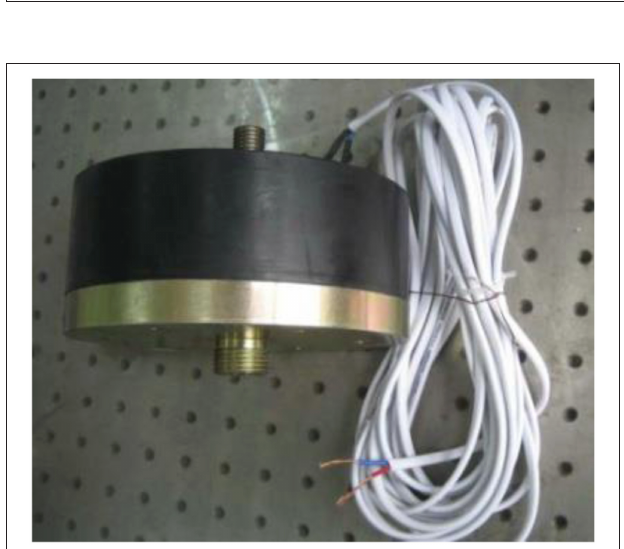
FIGURE 5 | Parameter experimented fitting flow figure to be identified in parameterized model.